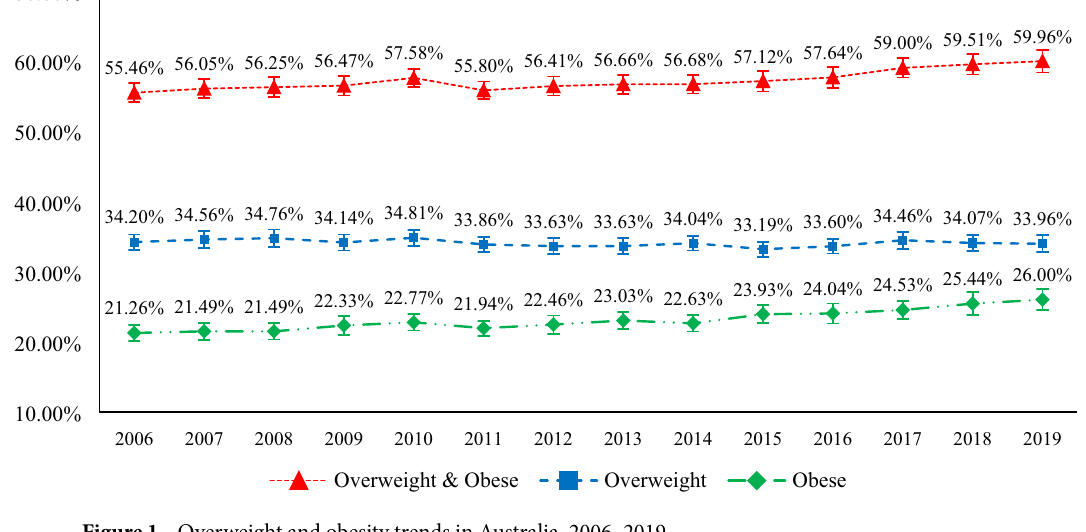
Figure 1. Overweight and obesity trends in Australia, 2006–2019.